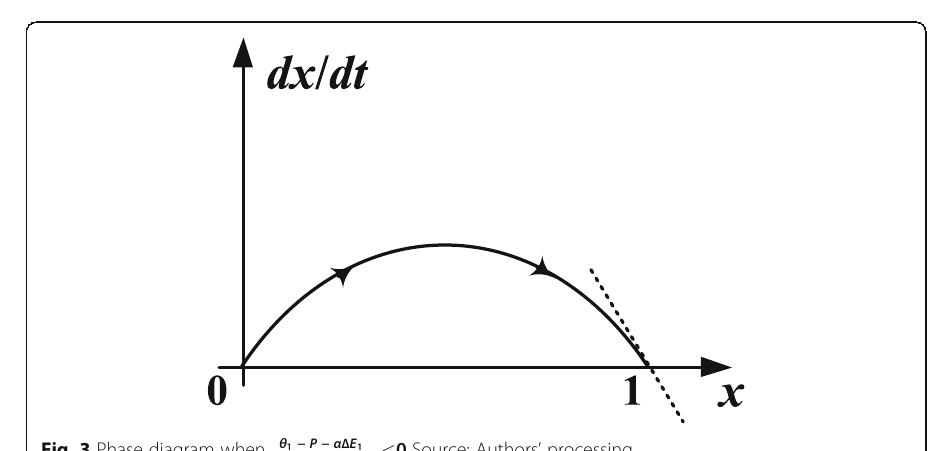
Fig. 3 Phase diagram when θ 1 − P − α Δ E 1 α